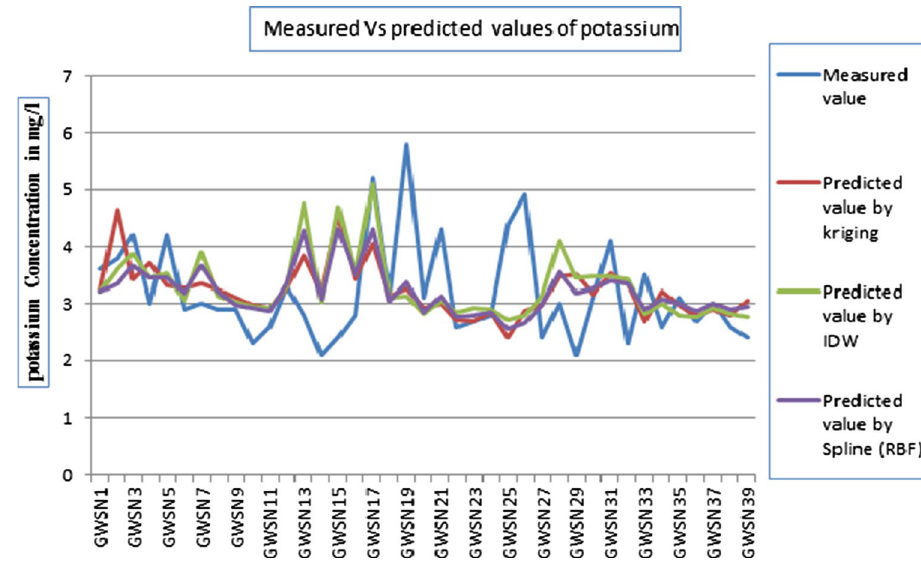
Fig. 7 Correlation result between measured and pre- dicted values of